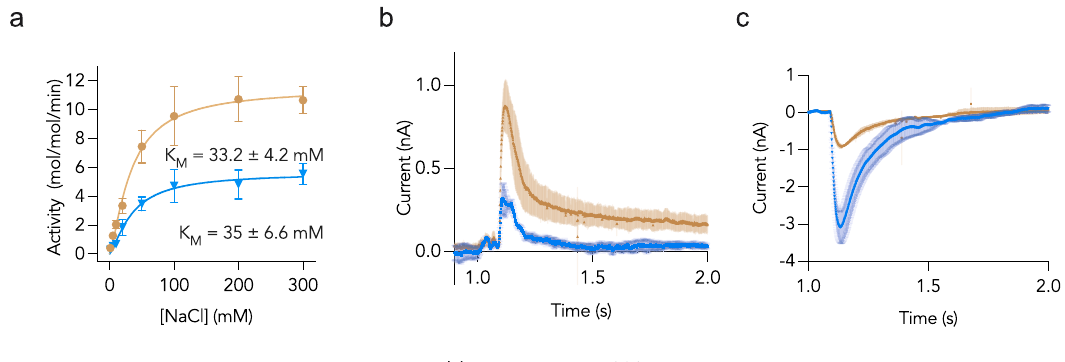
Fig. 3 | Impact of the P208R mutation on L-Asp transport and anion con- ductance. a Sodium dependence of transport at the fi xed concentration of 1 μ M L-AspinproteoliposomescontainingwildtypeGlt Tk (brown)andtheP208Rmutant (blue), measured with using radioactive aspartate. The plots were fi tted using the Hill model yielding a Hill coef fi cient of 1.36±0.1 (WT) and 1.37±0.2 (P208R). The errorbarsarerepresentativeofthestandarddeviationcalculatedontwobiological and three technical replicates; b Comparisons of transient currents induced by 100 μ M L-Asp at 200mM Na + on wild type and P208R. The bold lines are the